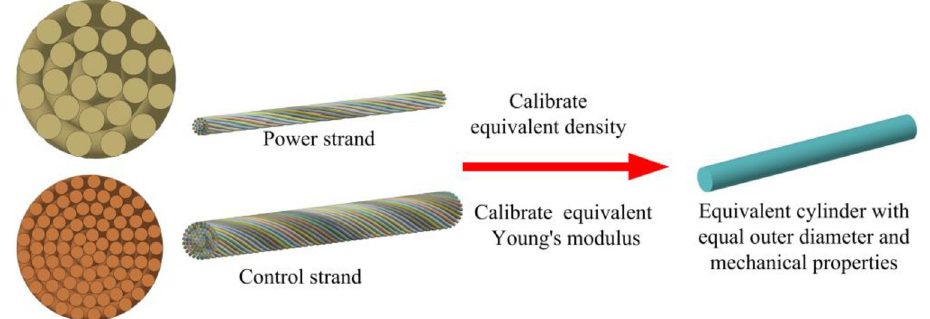
Fig 5. Equivalent schematic diagram of minimum analysis unit strand.